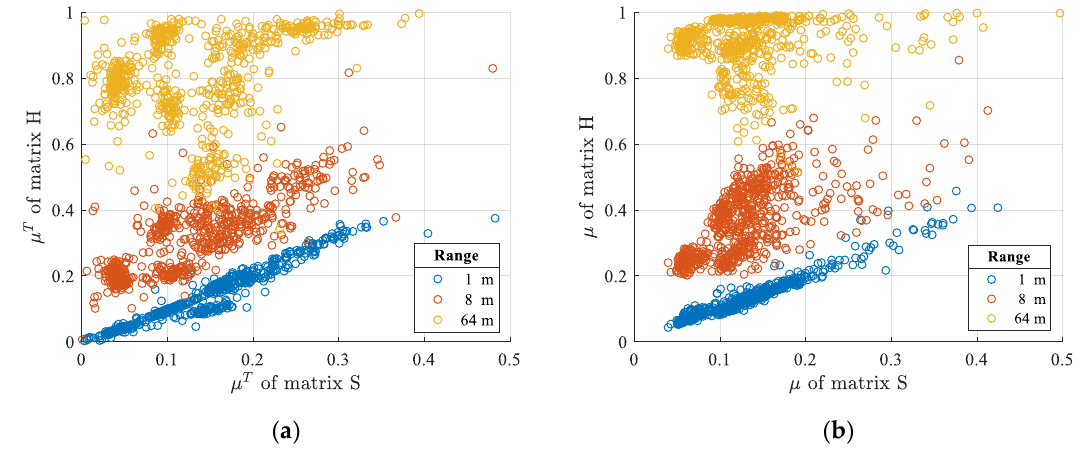
Figure 6. The coherence relationships obtained in the Ansoft HFSS simulation: ( a ) µ T ( H ) ← µ T ( S ) and ( b ) µ ( H ) ← µ ( S ) . A set of CELC arrays is introduced in sequence as a radiation source.